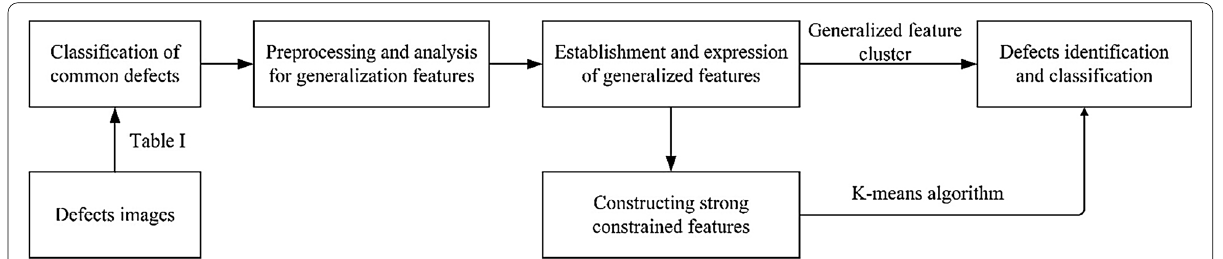
Figure 13 Flow chart of the proposed algorithm